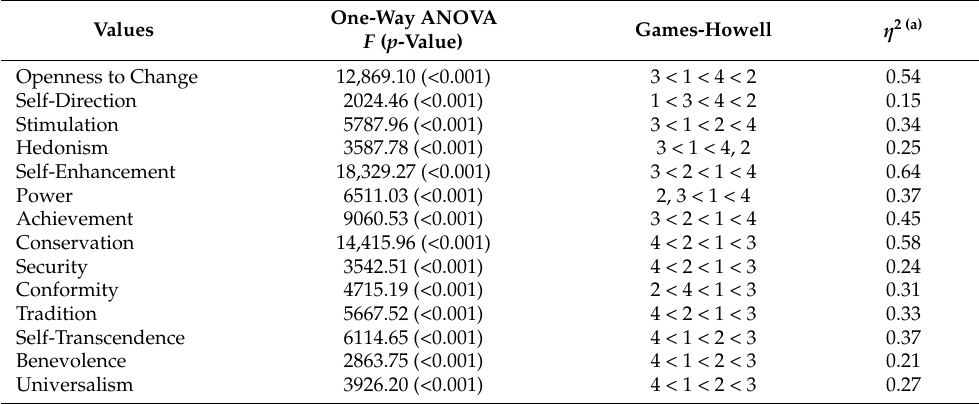
Table 3. One-way ANOVA results of basic and high order values means (test statistic Welch’s F and p -value) between clusters, Games–Howell multiple comparison results indicating the cluster’s ranking for significant differences found, and corresponding effect sizes ( η 2